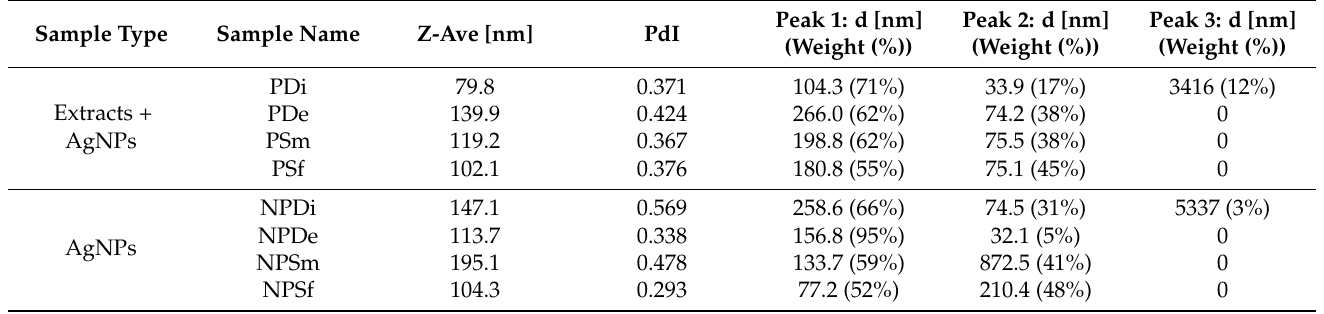
Table 5. DLS data recorded for Cannabis sativa leaf extracts with AgNPs and purified AgNPs.